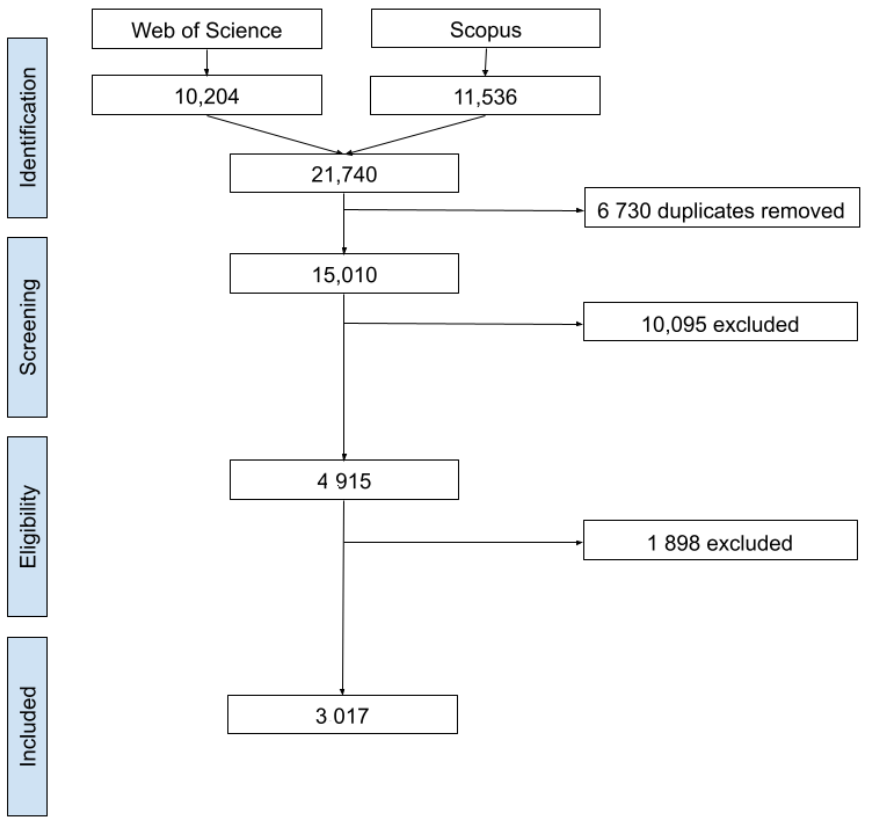
Figure 1. Systematic review flow